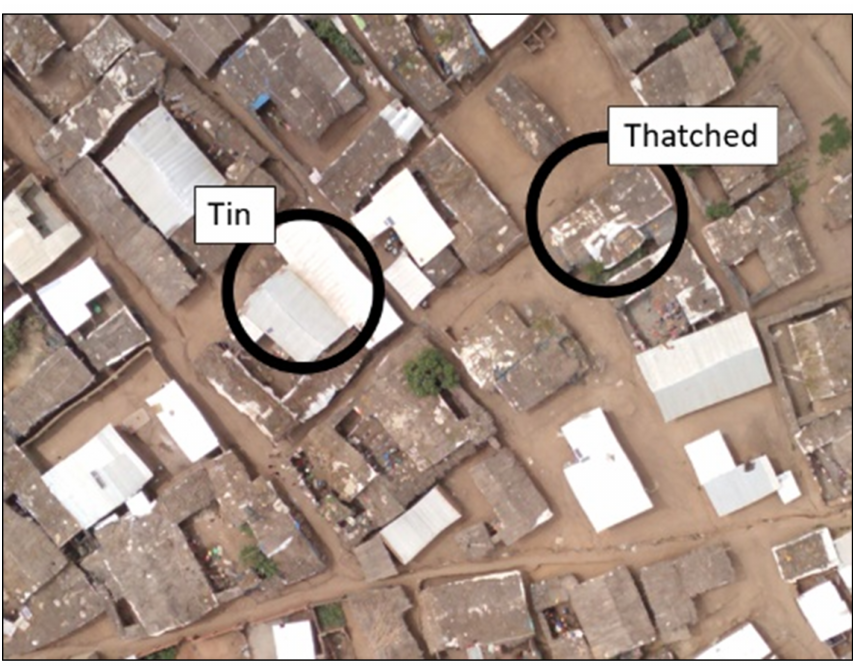
Figure 18. Examples of the two types of roofing at Dzaleka Refugee Camp: tin and thatched.